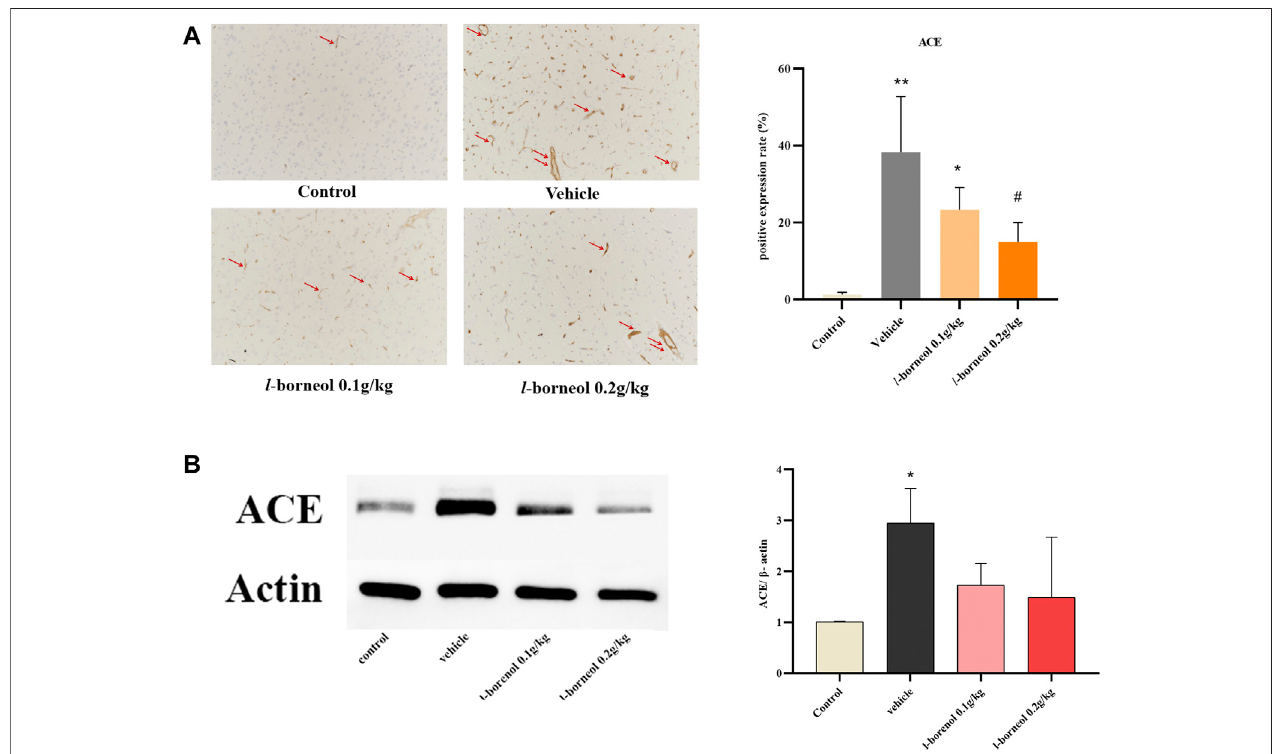
FIGURE8| IllustrationofACEexpressionusingIHCstainingandwesternblot( n (cid:2) 3). ** p < 0.01,comparedwiththecontrolgroup; # p < 0.05, ## p < 0.01,compared with the vehicle group, red arrow indicates positive